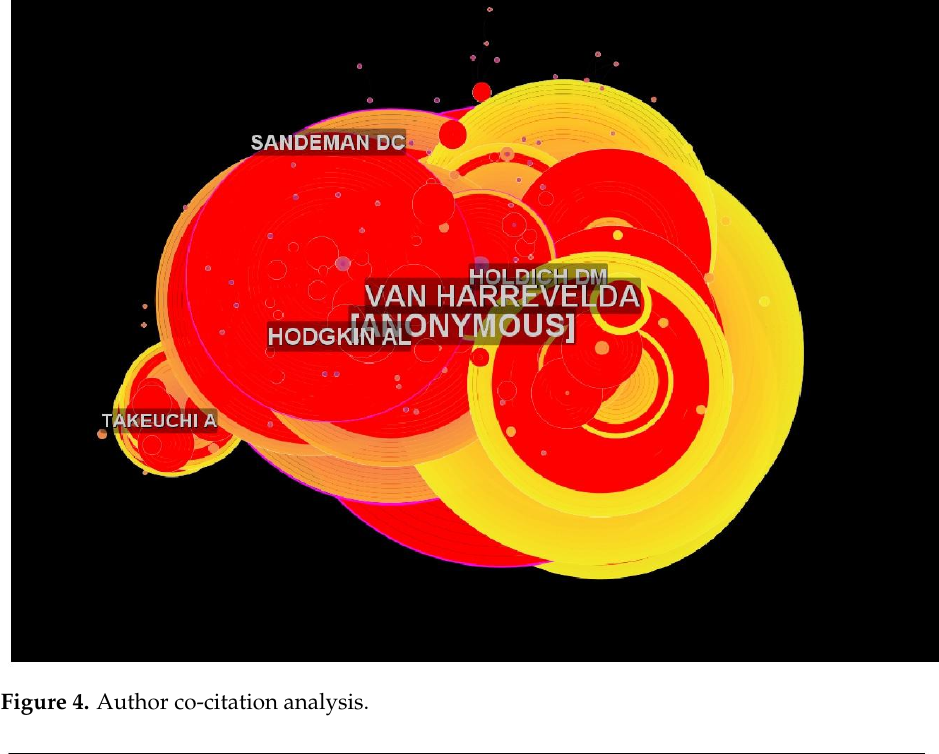
Figure 4. Author co-citation analysis. Table 6. Top 10 journals according to co-citation scores.